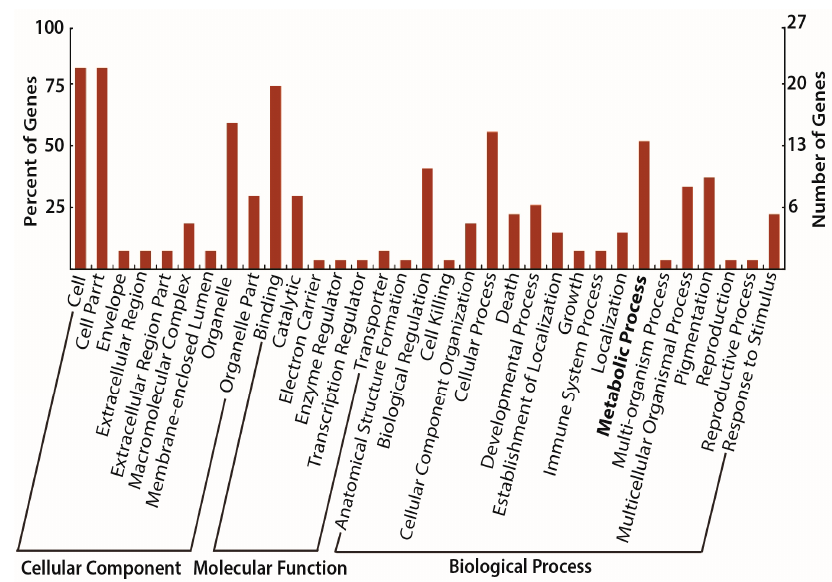
Figure 6. Gene ontology classification of genes with H3K4me3 enrichment histone modification due to high fat exposure. A representative gene ontology analysis of candidate genes corresponding to H3K4me3 peak enrichment in the diet exposed group (HC) is shown. Gene ontology of ‘metabolic process’ is chosen for the downstream analyses.